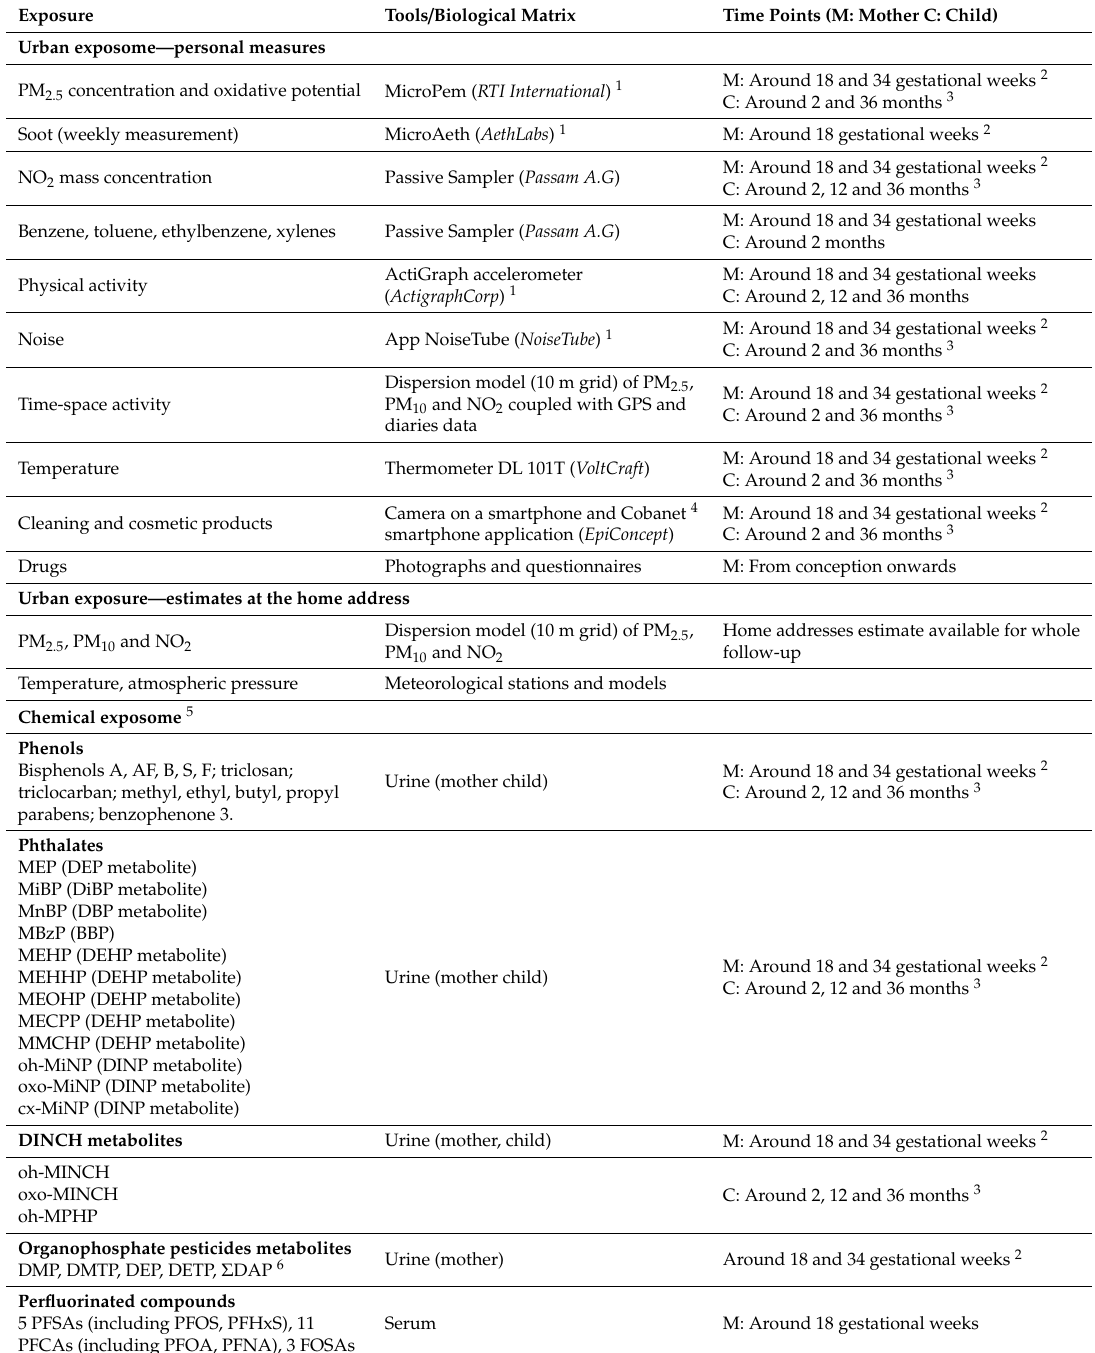
Table 4. Assessment of exposure to environmental factors in the cohort